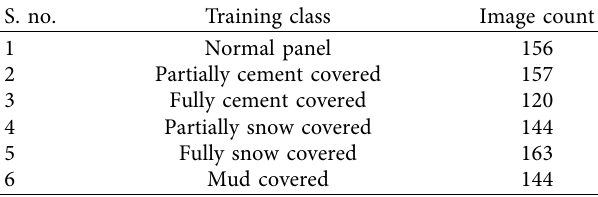
Table 1: Number of real images used in each training class. S. no.